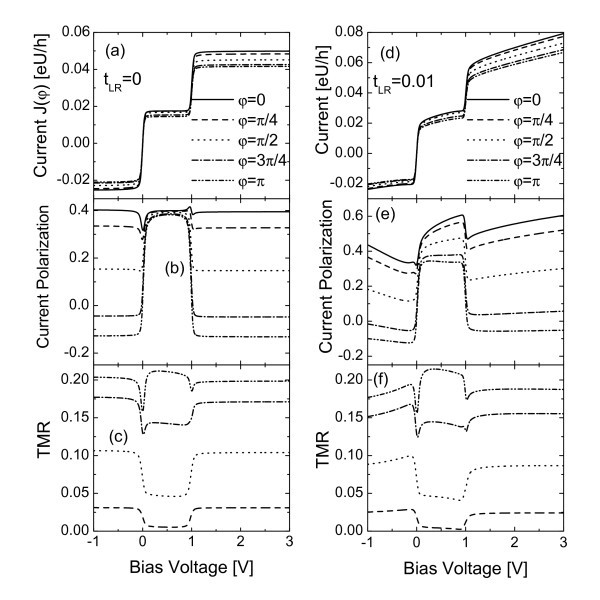
Total current J, current spin polarization p and TMR each as a function of the bias voltage for different values of φ. tLR = 0 in Figs. (a) to (c) and tLR = 0.01 in Figs. (d) to (f). The other parameters are intradot energy level εd = 0, temperature T = 0.01, and polarization of the leads PL = PR = 0.4.